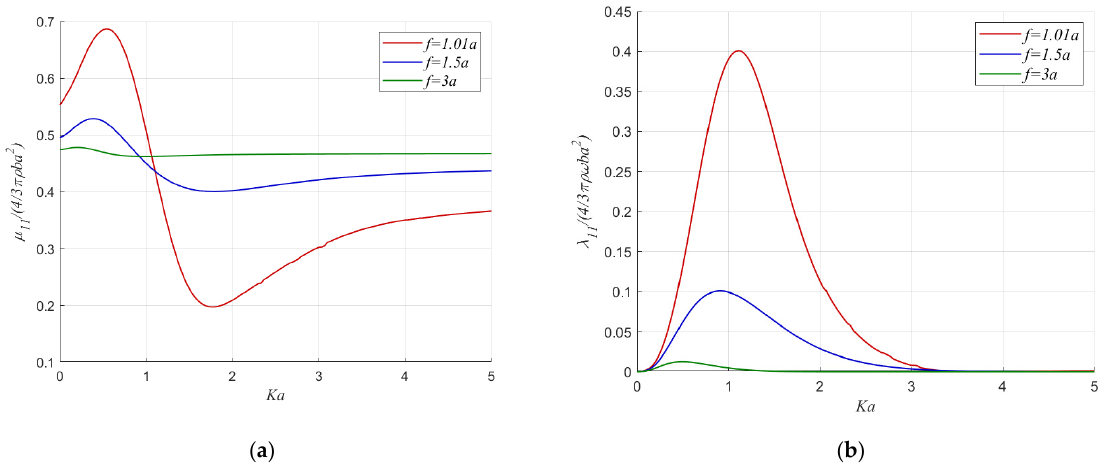
Figure 8. Normalized hydrodynamic coefficients in surge for a/b = 1.1, h = 10a: ( a ) added mass; ( b ) hydrodynamic damping.